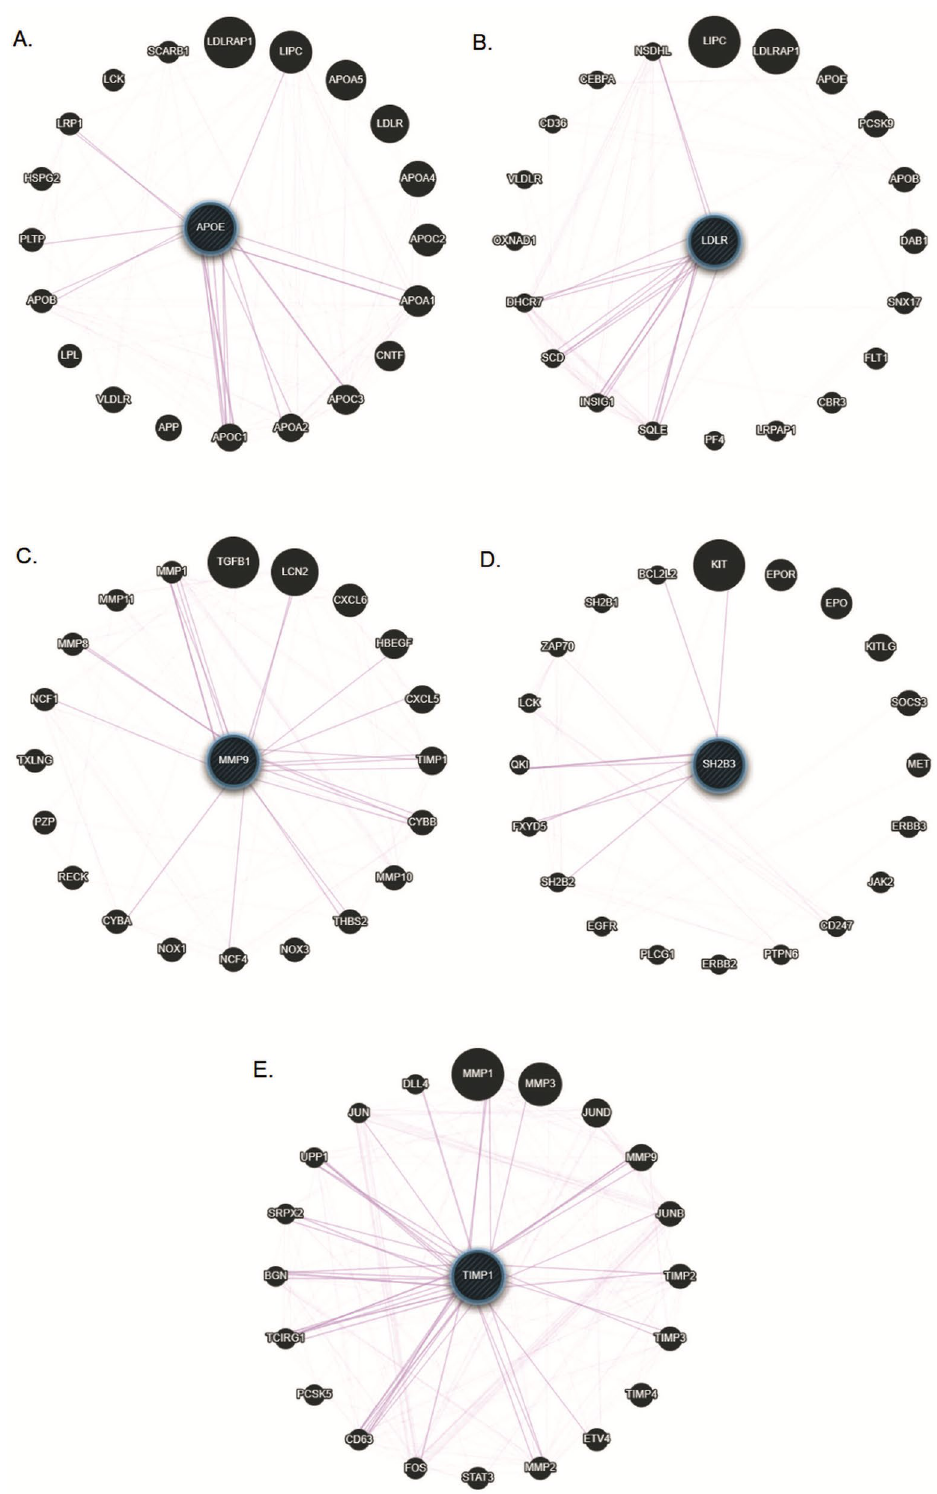
Figure 4. Concentric bipartites by GeneMANIA represents Co-expression networks of A.APOE B.LDLR C.MMP9 D.SH2B3 E.TIMP1